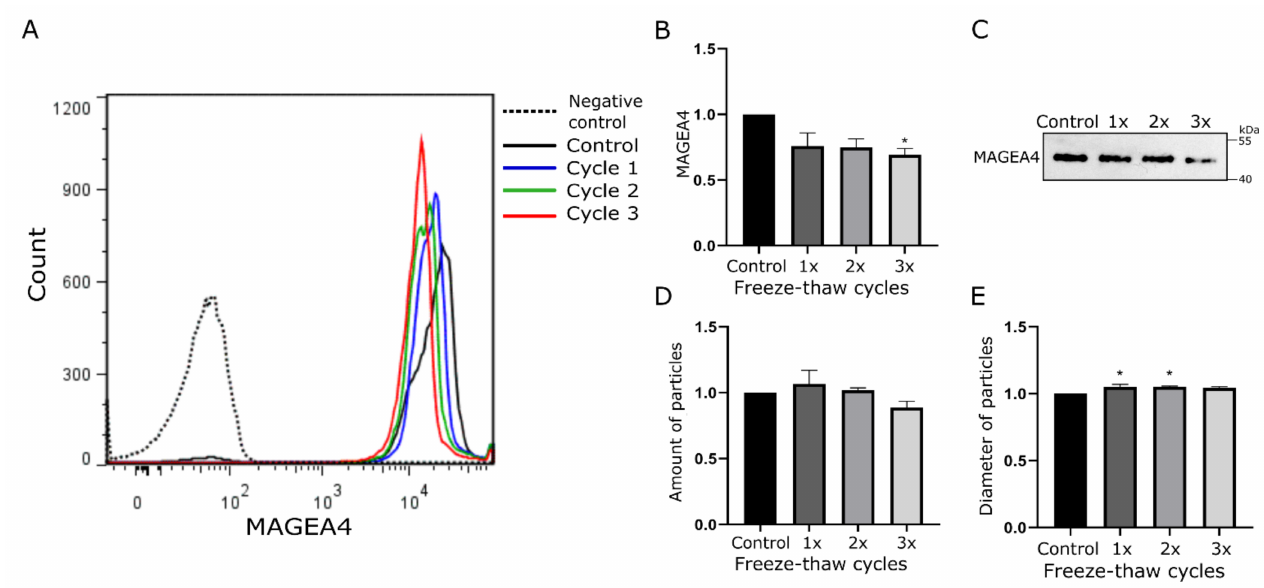
Figure 2. The effect of freezing-thawing cycles on MAGEA4-EVs. MAGEA4-EVs were subjected up to three freeze-thaw cycles. A single cycle comprised of 1 h of freezing at − 20 ◦ C and 20 min of thawing at room temperature. ( A ) Analysis of MAGEA4 on the surface of EVs using flow cytometry with anti-MAGEA4 and Alexa 488-conjugated secondary antibodies. ( B ) The relative amount of MAGEA4 on the surface of EVs (MFI) analyzed by flow cytometry. ( C ) Western blot analysis of samples with anti-MAGEA4 antibodies. ( D ) The amount and ( E ) average diameter of vesicles as measured by the NTA. Data shown are average of three independent experiments. In all cases, the relative values where the control was set as 1 is shown. *—The difference of the sample value compared to the control sample value is statistically significant with p -value